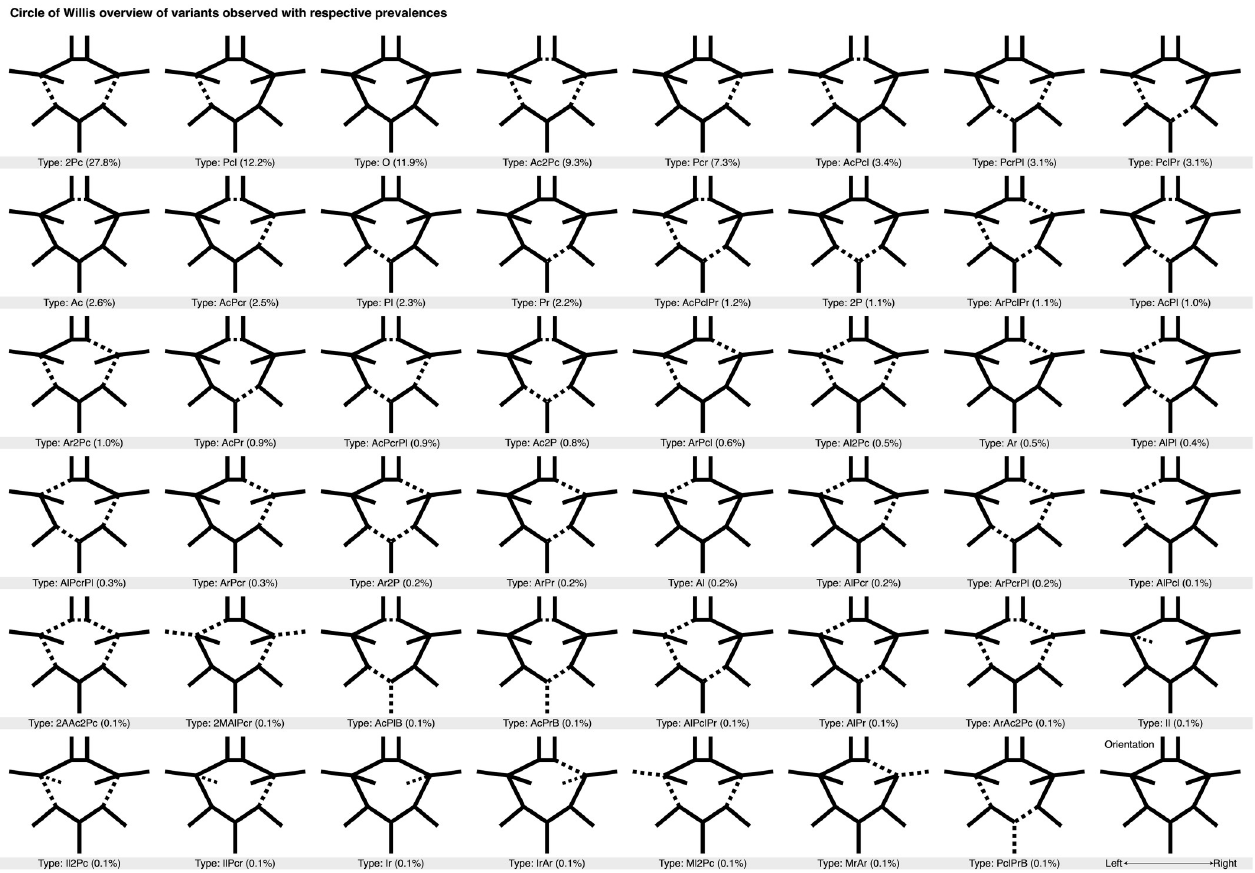
Fig 3. Complete graphical overview of all Circle of Willis variants observed in the current study. All variants are sorted first by (descending) frequency and then, in case of equal frequencies, by alphanumerical ordering. Each variant’s name is put together by the missing segments with the following notation: O = Complete variant (no missing arteries), Ac = Anterior communicating artery, A = Anterior cerebral artery, Pc = Posterior communicating artery, P = Posterior cerebral artery, I = Internal carotid artery, M = Middle cerebral artery, B = Basilar artery, while the suffixes “r” and “l” denote right and left lateralization of arteries. The prefix “2” denotes bilateral missing arteries.